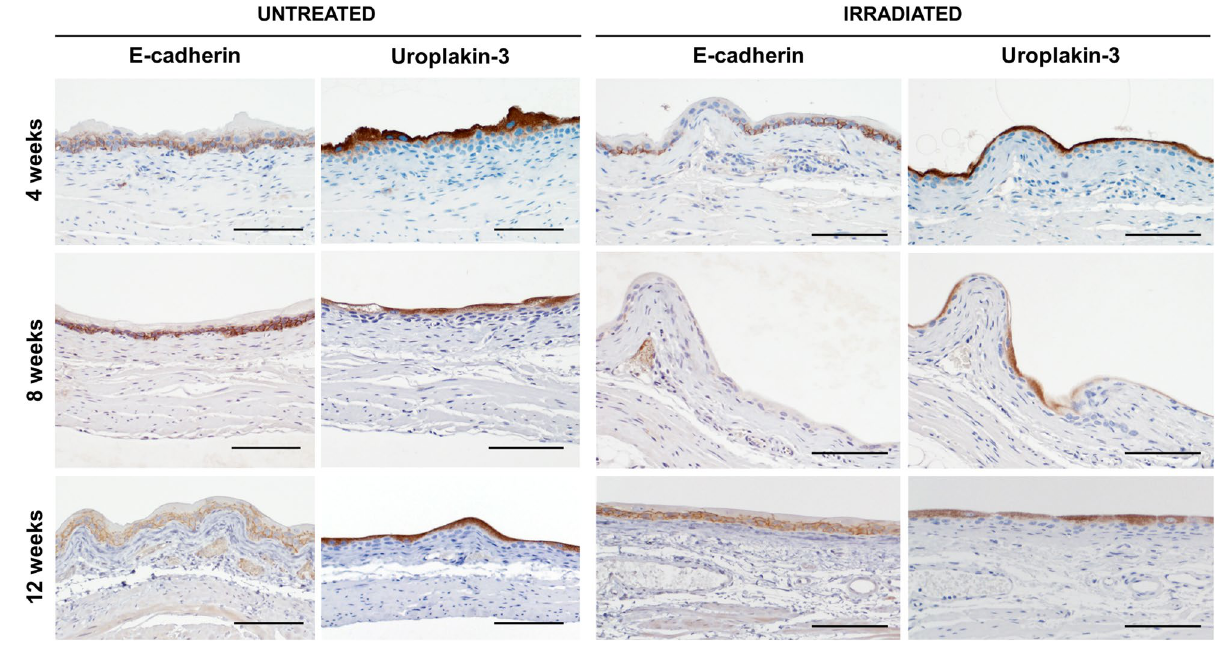
Figure 3. Loss of urothelial cell-adhesion (E-cadherin) and Uroplakin III associated with acute phase of RC. Bladder sections of untreated and irradiation mice at 4-, 8- and 12-weeks post-irradiation were stained with E-cadherin or Uroplakin III (brown) and counterstained with hematoxylin (blue). Scale bar = 100 µm.